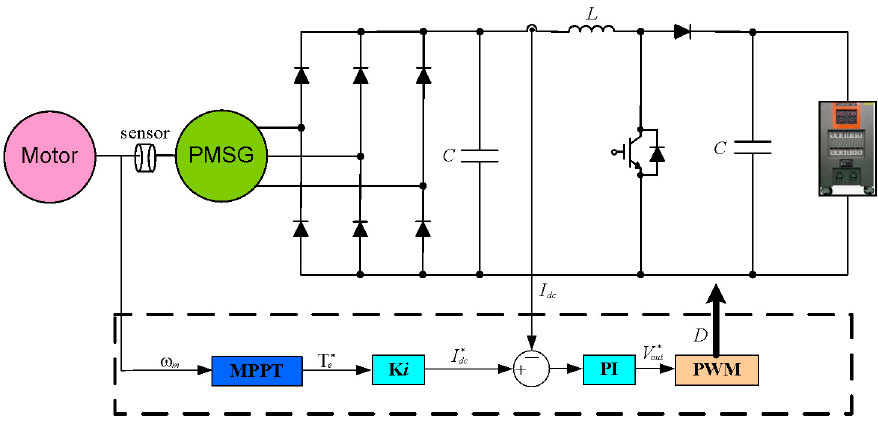
Figure 4. DC/DC boost converter control block